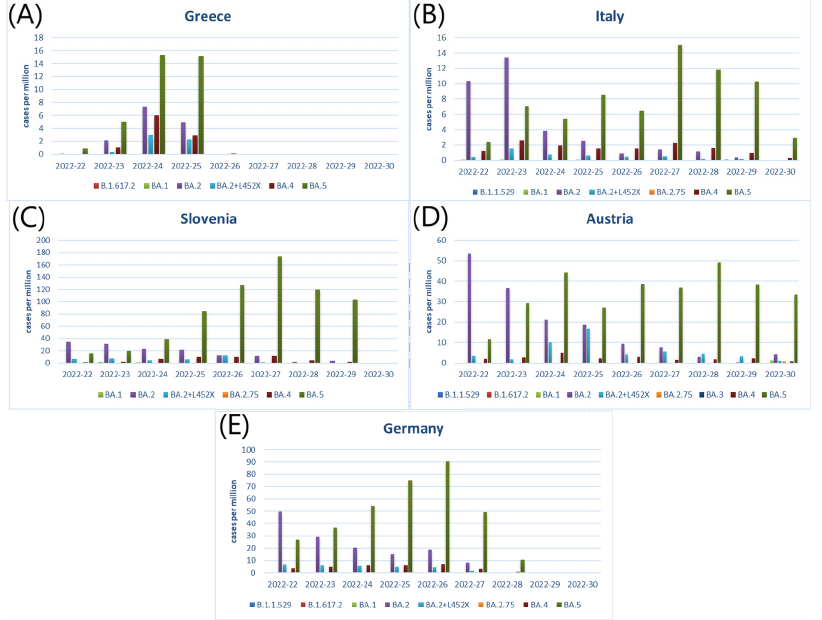
Figure 2. SARS-CoV-2 variants in ( A ) Greece, ( B ) Italy, ( C ) Slovenia, ( D ) Austria and ( E ) Germany in the period of weeks 22 to 30 2022. Int. J. Environ. Res. Public Health 2022 , 19 , x